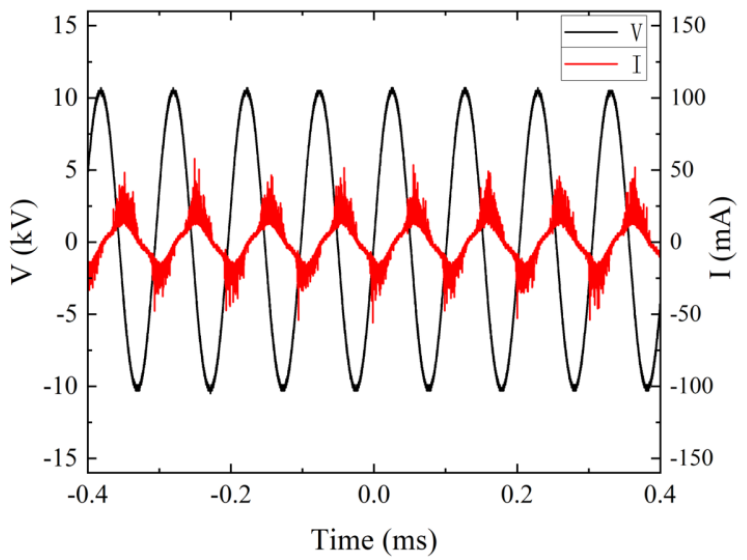
Figure 6. The voltage and current waveform of the 4−DBD tube array.